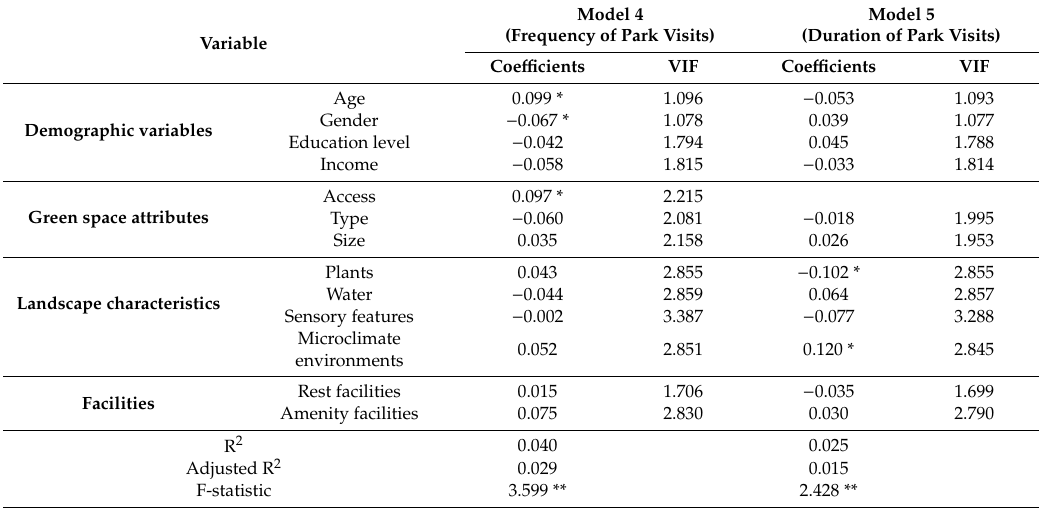
Table 6. Multiple regression results with park use behavior as the dependent